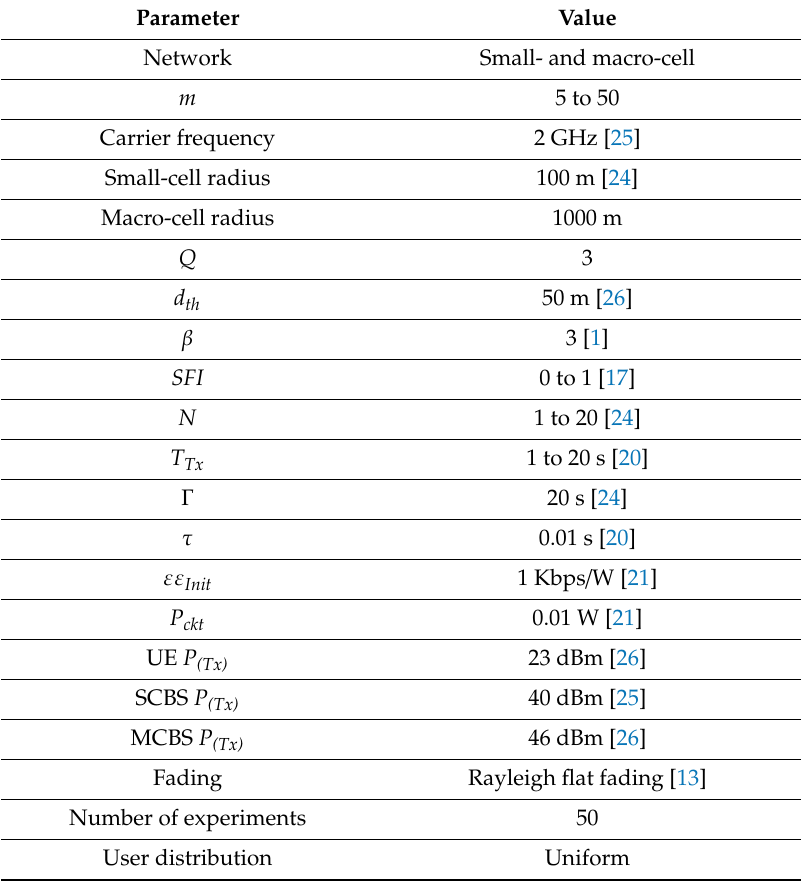
Table 3. Simulation